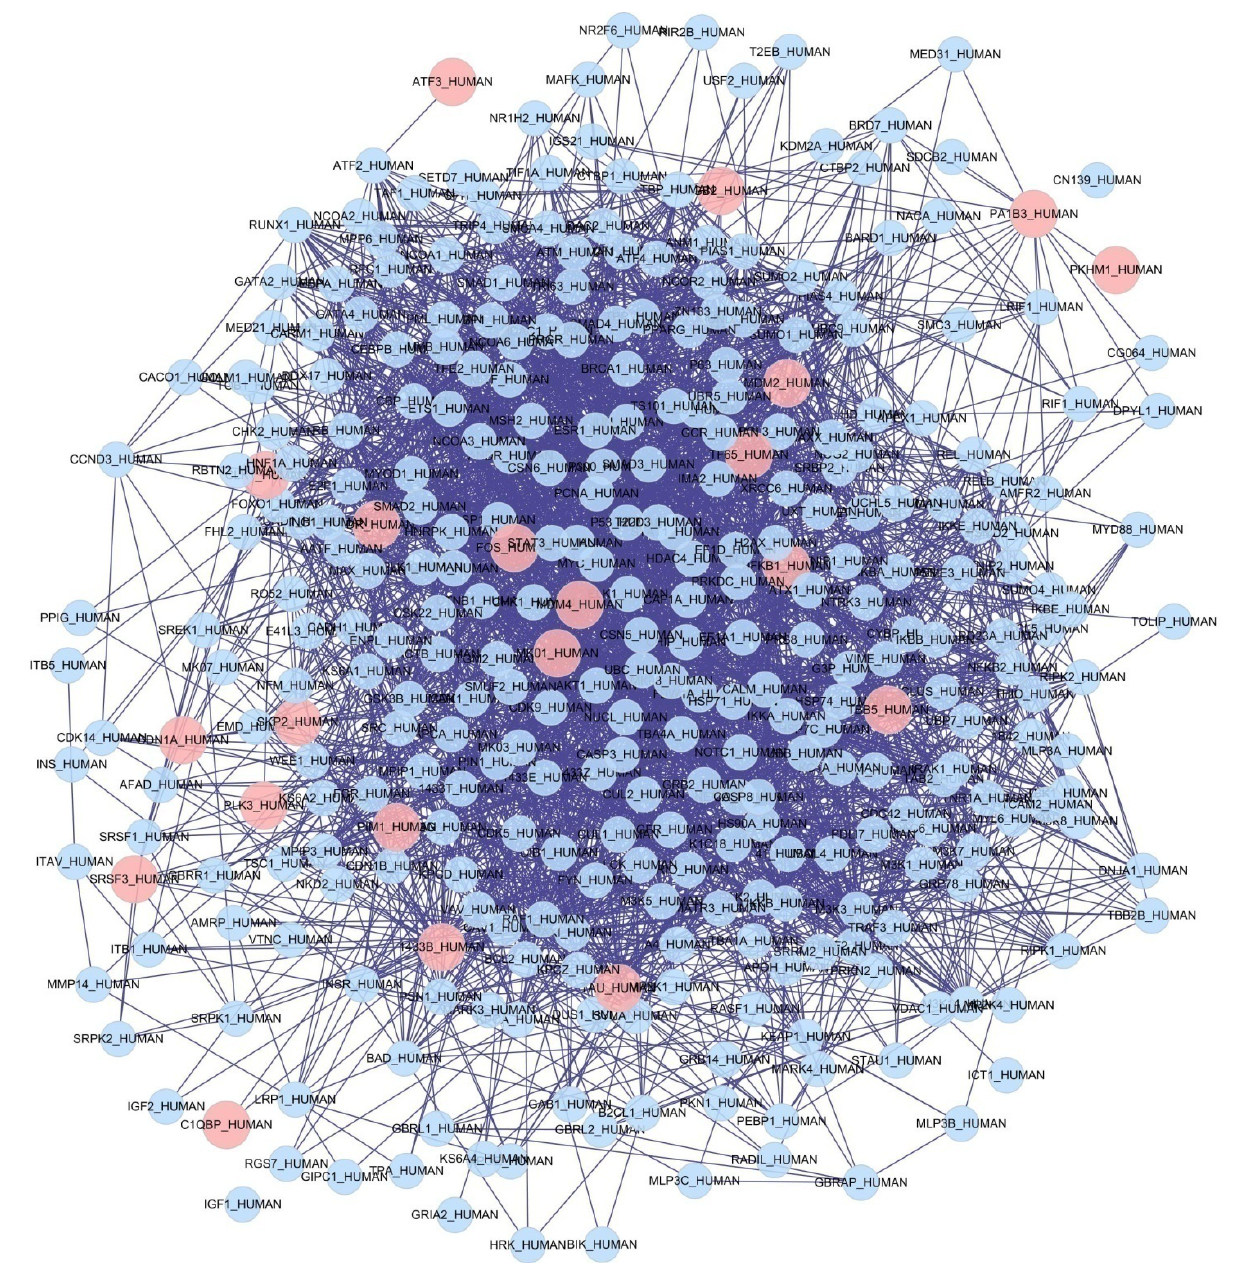
Figure 1. Common network of two PPI networks based on differentially expressed genes of HBEC exposed to PM and human target proteins of curcumin. Red cycles represent 2.5 seed nodes, and blue cycles represent neighbor nodes. All edges represent interactions between the